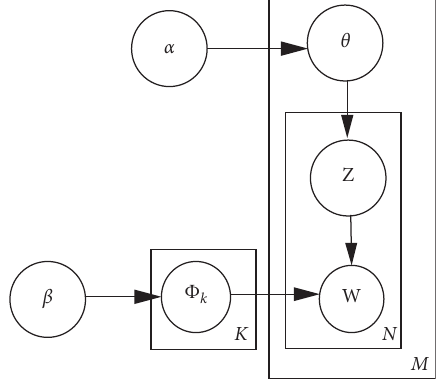
Figure 1: Schematic diagram of the LDA